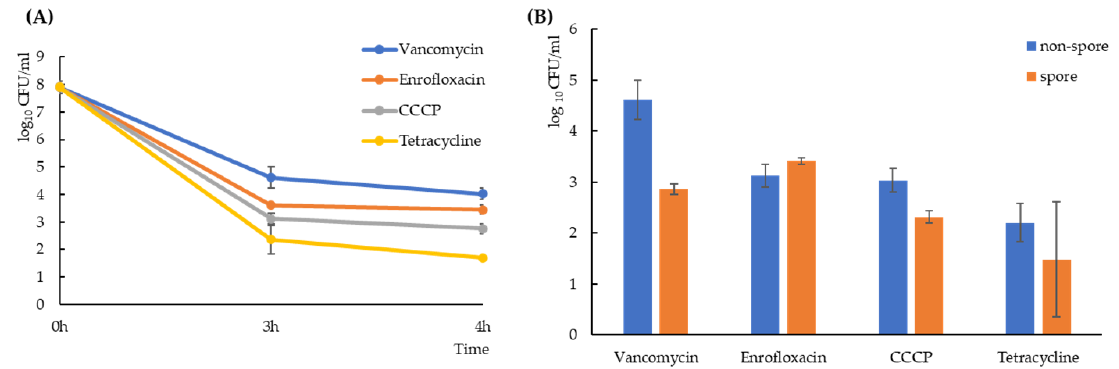
Figure 1. Exposure to various antimicrobials generated different levels ( p < 0.05) of Bacillus subtilis spores and non-spore cells. ( A ) Time-kill curves depicting the total number of surviving cells (including spores and non-spore cells) after 3-h vancomycin (blue), enrofloxacin (orange), CCCP (gray) or tetracycline (yellow) exposure. Quantification was performed by plating treated cultures on LB agar plates and counting colonies. ( B ) The bar-graph shows the number of B. subtilis spores (orange) or non-spore cells (blue) after 3 h antimicrobial exposures. The number of spores were assessed after killing all non-spore cells by pre-heating treated cultures in 70 °C for 30 min, placing them on ice for 15 min and subsequent plating. The numbers of non-spore persister cells were then calculated by subtracting the number of spores from the total number of cells cultured after antimicrobial ex- posure.